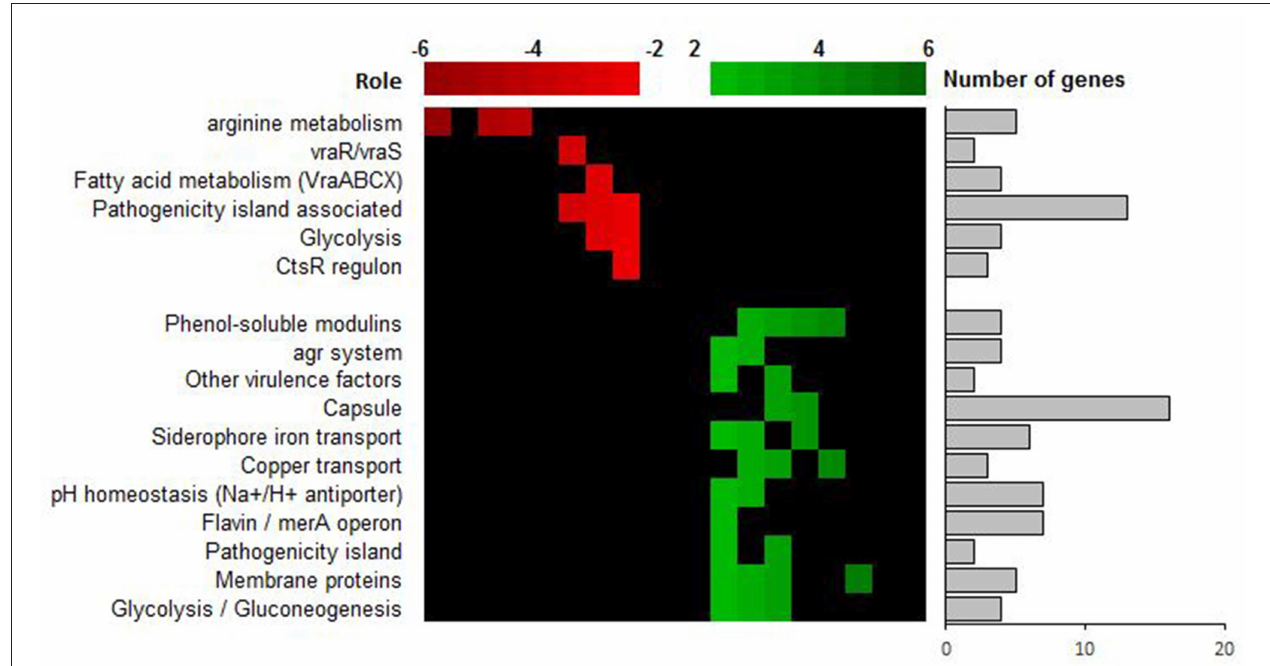
FIGURE 3 | Transcriptional analysis of SCV strain ST20130945 and parental strain ST20130944. Up-regulated genes (in green) are differentially up-regulated in ST20130945 compared to the parent strain ST20130944, and the down-regulated genes (in red) are differentially down-regulated in ST20130945 compared to ST20130944. The heat map analysis highlights the role of the genes for which the differential expression was